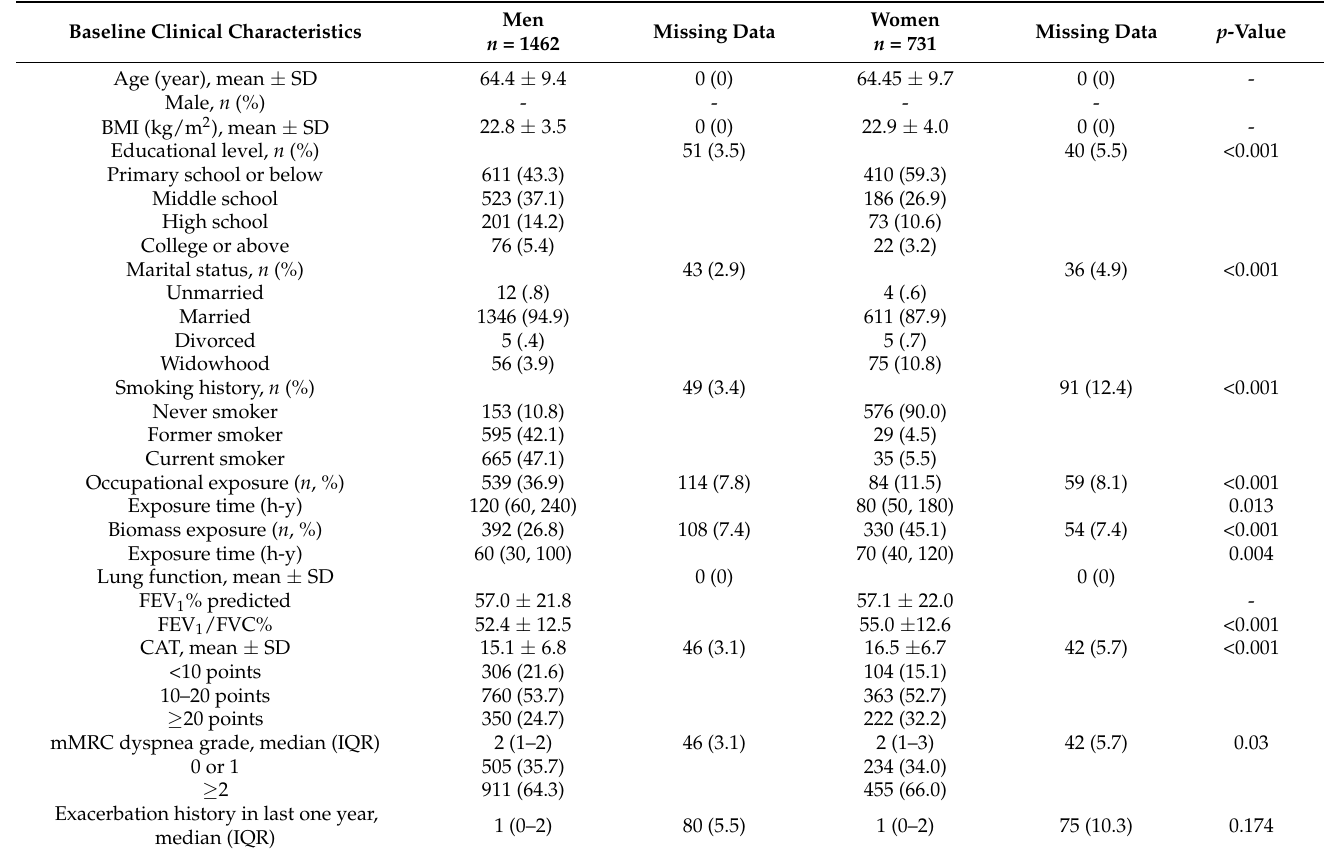
Table 1. Baseline and clinical characteristics of COPD patients.